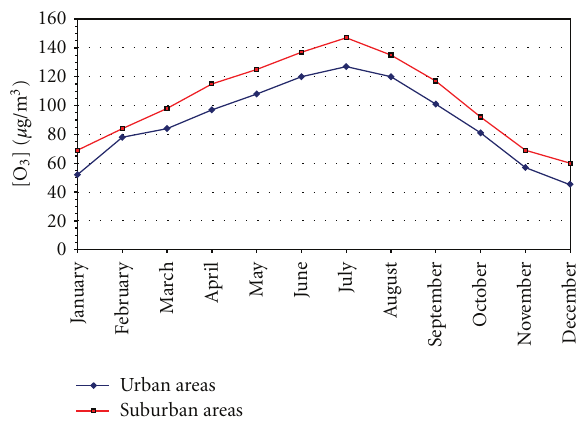
Figure 4: Annual variation of mean maximum monthly ozone concentrations for the urban and suburban areas within the GAA. Period